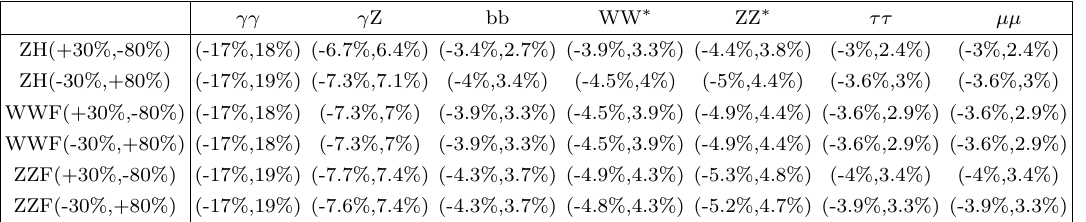
Table 12 . Possible deviations in signal strengths (in percent) caused by top-quark operators, in Higgs production (WWF for WW fusion and ZZF for ZZ fusion) and decay channels, at an e + e (cid:0) collider at 350 GeV centre-of-mass energy. Only the coe(cid:14)cient of O t’ is allowed to vary within the current constraints, described in table